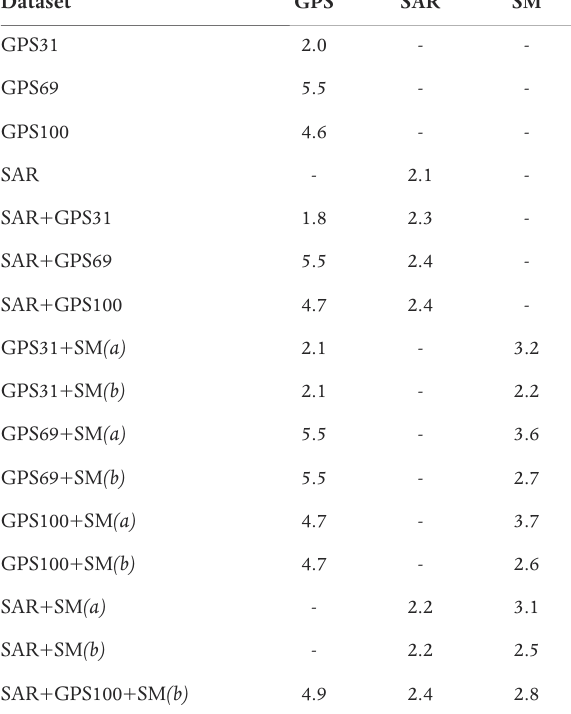
Table 4. RMS of residuals between observed and modeled coseis- mic displacements obtained from the linear inversion of observed data. For the joint inversions, the RMS was computed with respect to each dataset separately. RMS is in units of